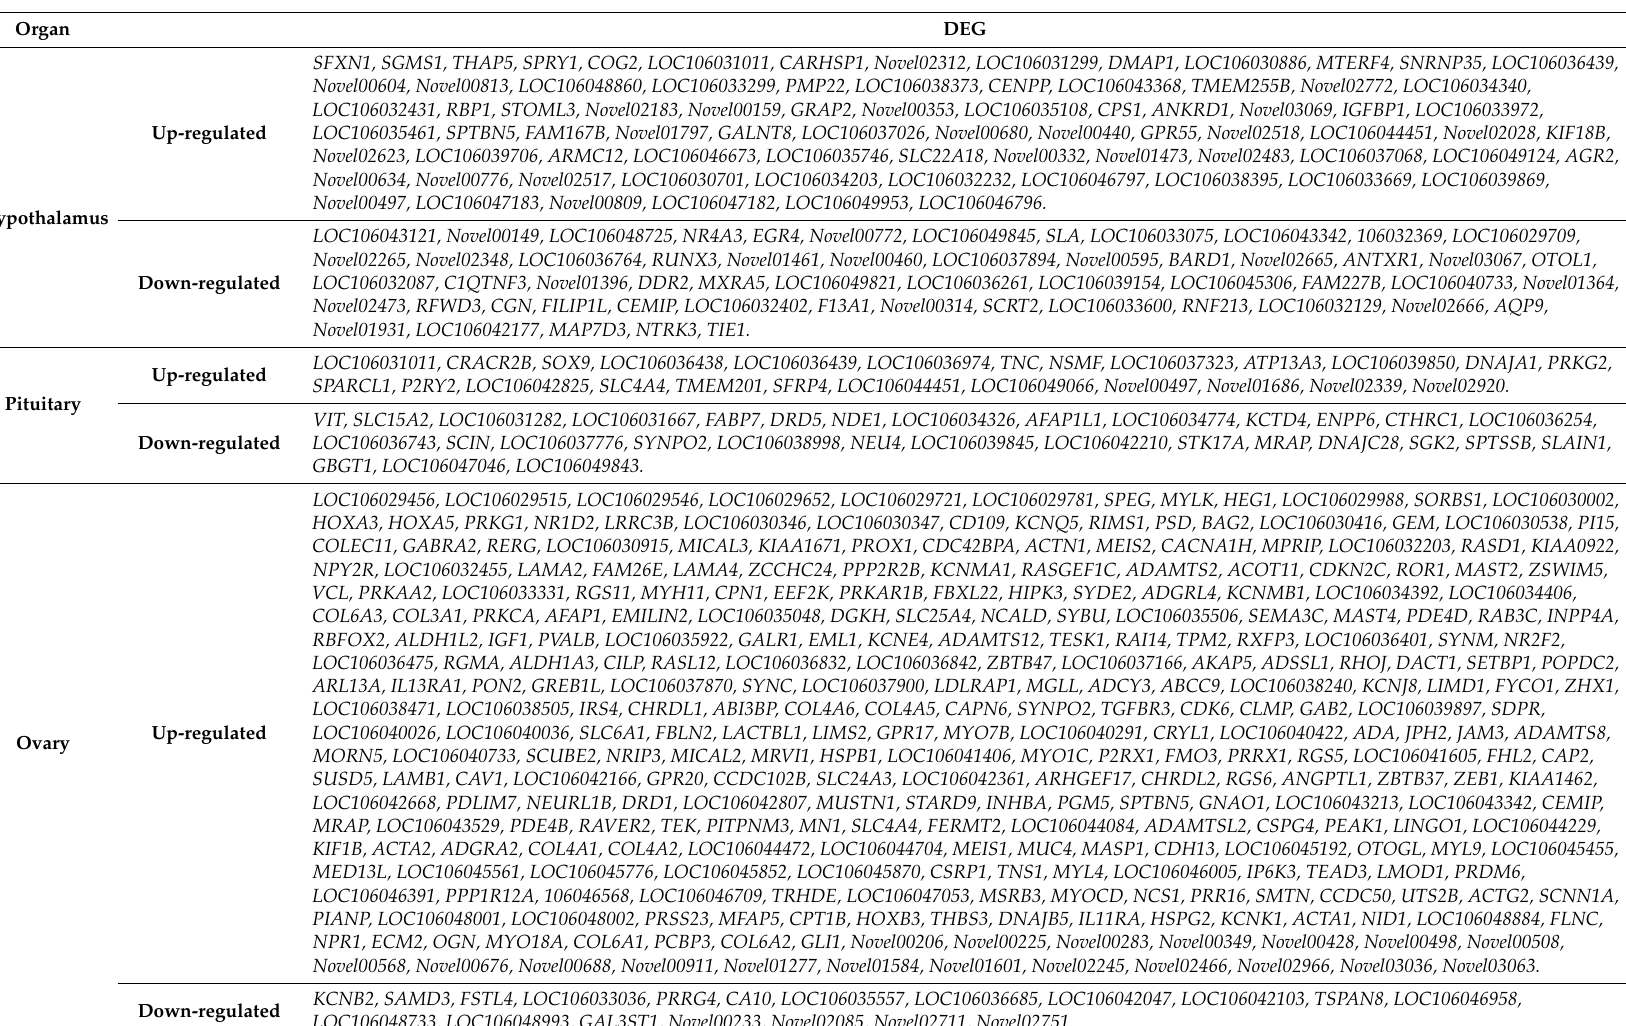
Table 2. Di ff erentially expressed genes in the hypothalamus-pituitary-gonadal